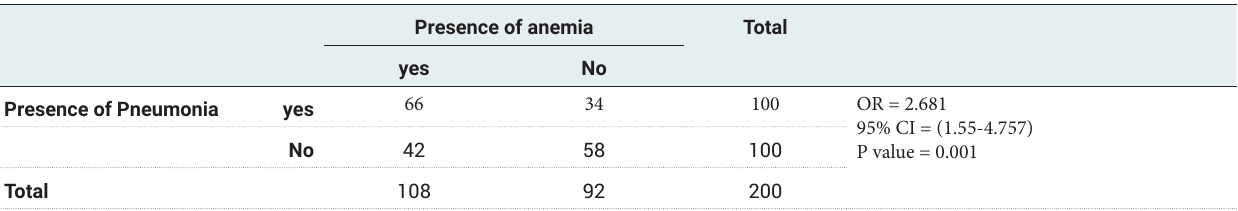
Sensitivity: 66%, Specificity: 58%, PPV: 61%, NPV: 63%